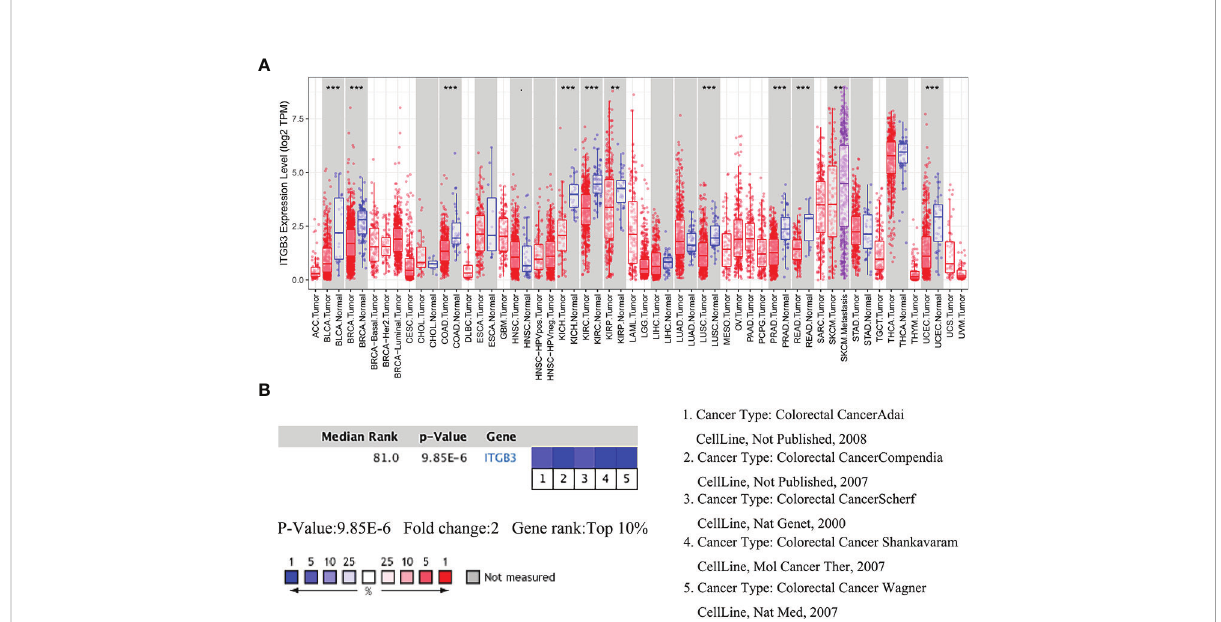
Figure 2A). Subgroup analysis revealed that the downregulation Overall Survival(OS) (log-rank p = 0.050, HR = 2.29 (1.00 – 5.37); Figure 2B) and fi ve-year OS (log-rank p = 0.032, HR = 1.99 (1.06 – 3.79); Figure 2C) in patients with COAD (Table